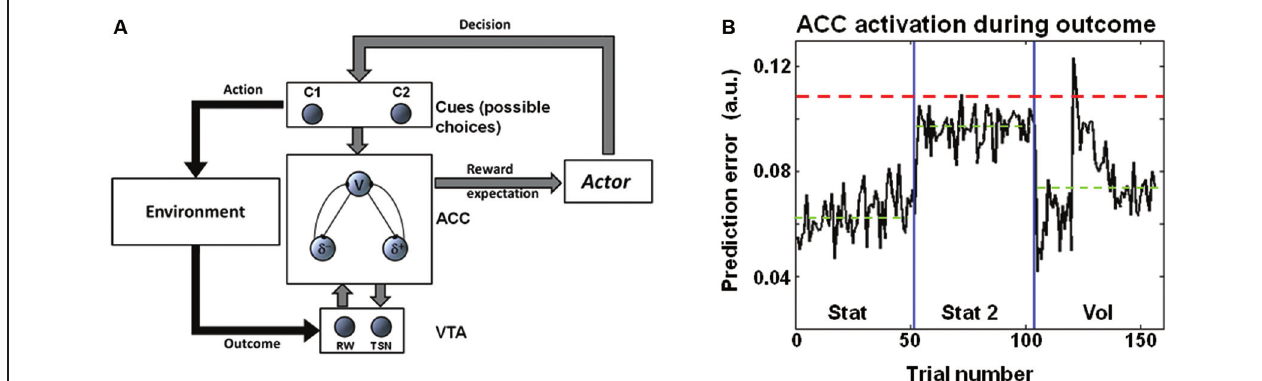
from the ACC module, allowing dopamine shifting from reward period to cue period. (B) Results of RVPM simulations supporting the model, from Silvetti et al. (2013). The plot shows the ACC module PE signal (sum of all the units’ activity) as a function of trial number, in three different SEs. Although the average PE signal (green dashed line) is highest during Stat2 (highly uncertain environment), Vol environment triggers very strong phasic PE activity. This property can be exploited for volatility detection, e.g., the red dashed line indicates a possible threshold for volatility detection based on PE